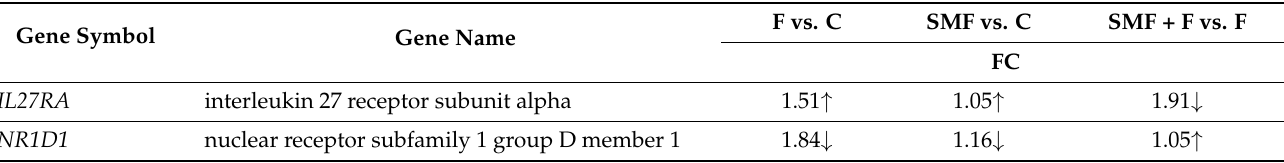
Table 2. Validation of the microarray data using